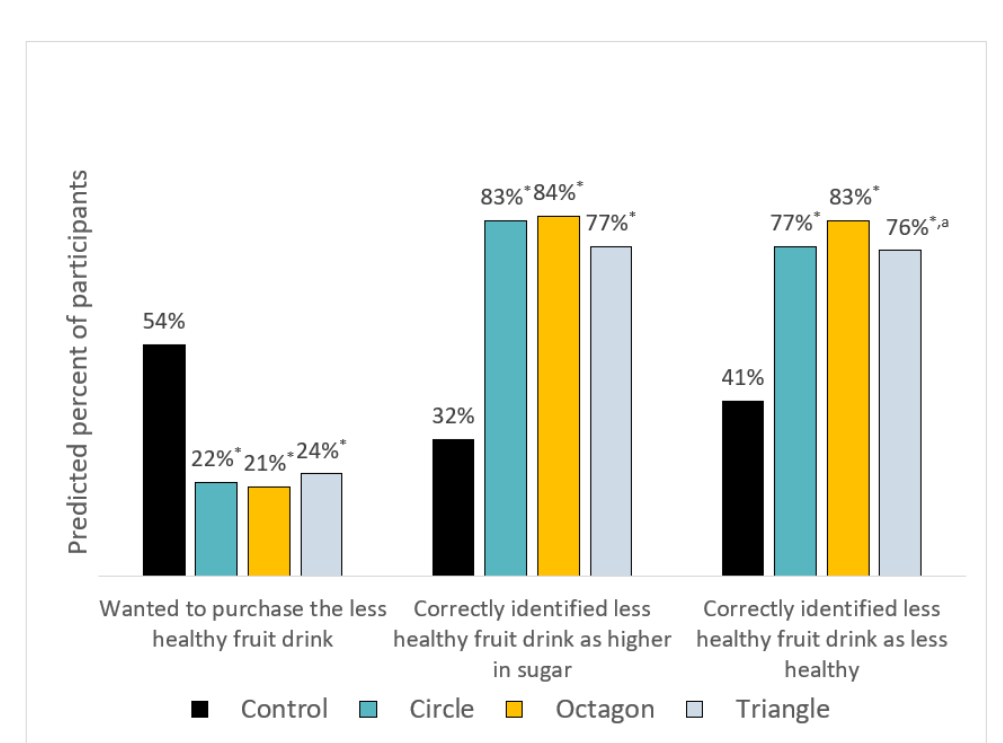
Figure 2. Predicted percent of participants who wanted to purchase the less healthy fruit drink, and percentage who correctly identified the less healthy fruit drink as higher in sugar and as unhealthy by label type. Note . * Warning is statistically different from control, p < 0.001. a Warning is statistically different from octagon warning, p < 0.05. There were no differences between circle and triangle warnings. Predicted percent, standard errors, and p -values for contrasts can be found in Table A4.